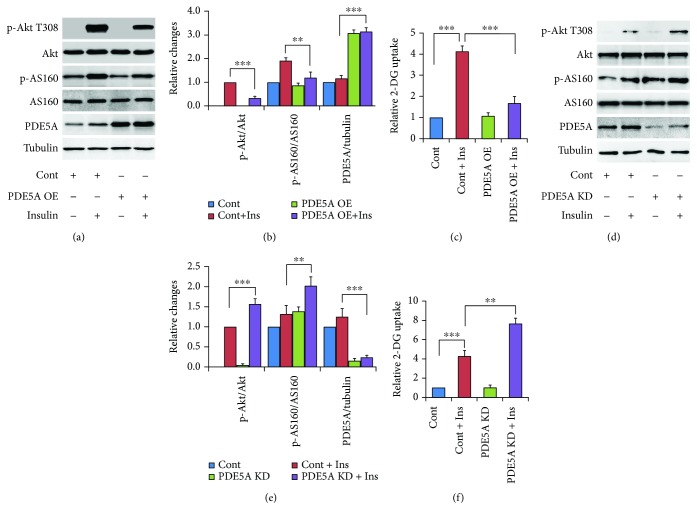
Effects of PDE5A on insulin signaling in C2C12 myotubes. (a) Representative western blots showing the insulin- (INS-) stimulated phosphorylation of Akt T308 and AS160 in the cells with PDE5A overexpression (OE); (b) quantification of phosphorylated Akt T308, phosphorylated AS160, and PDE5A protein in (a); (c) insulin-stimulated 2-DG uptake in the cells with PDE5A overexpression; (d) representative western blots showing the phosphorylation of Akt T308 and AS160 in the cells with PDE5A knockdown (KD); (e) quantification of phosphorylated Akt T308, phosphorylated AS160, and PDE5A protein in (d); (f) 2-DG uptake in the cells with PDE5A knockdown. N = 4. ∗∗P < 0.01, ∗∗∗P < 0.001 vs. the indicated group.